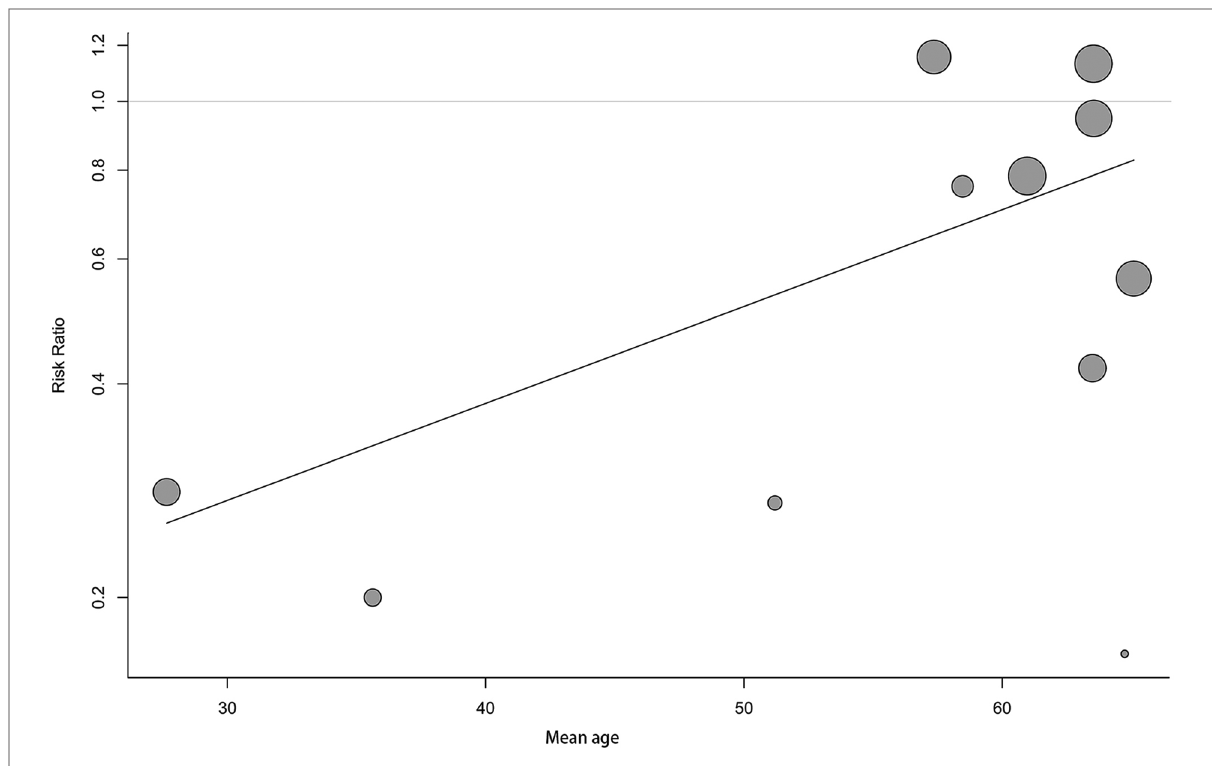
FIGURE 9 Bubble plot showing the correlation between mean age of patients and risk